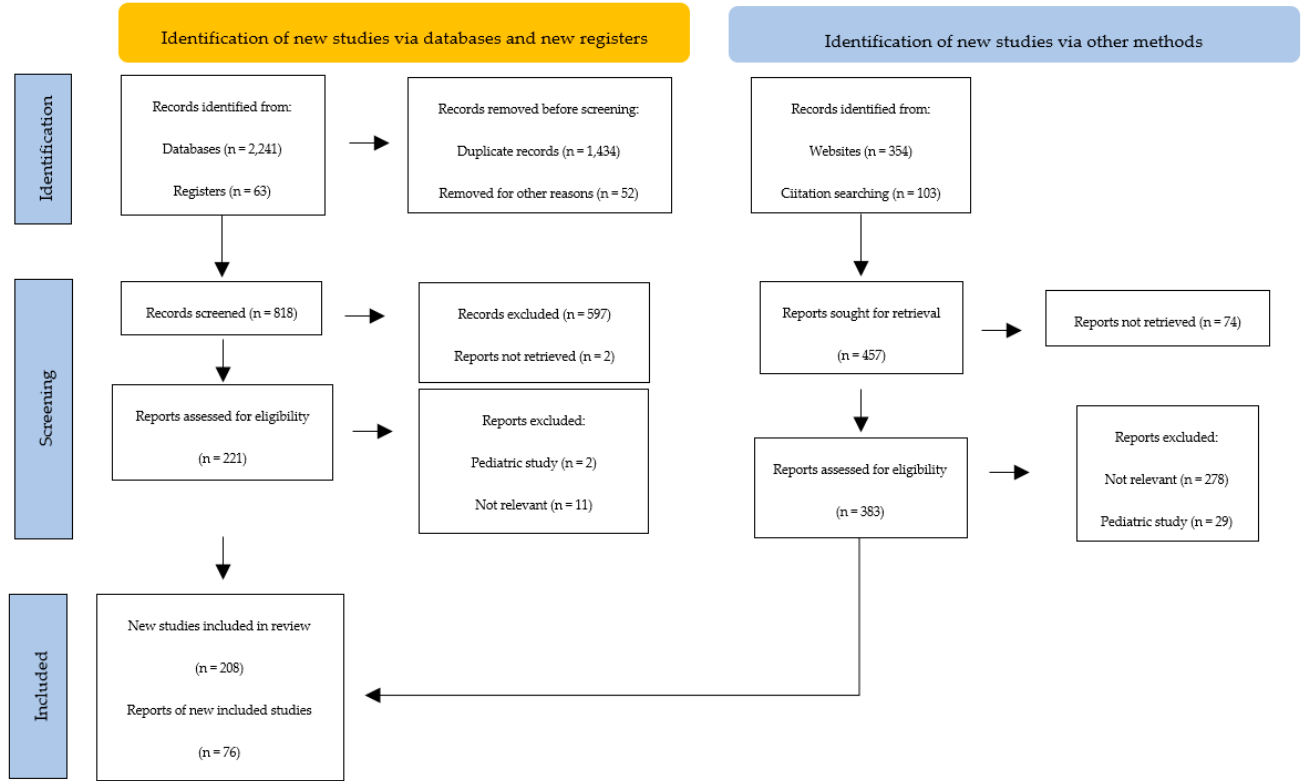
Figure 1. PRISMA fl ow diagram. Method for the selection of articles for this review. Figure 1. PRISMA flow diagram. Method for the selection of articles for this